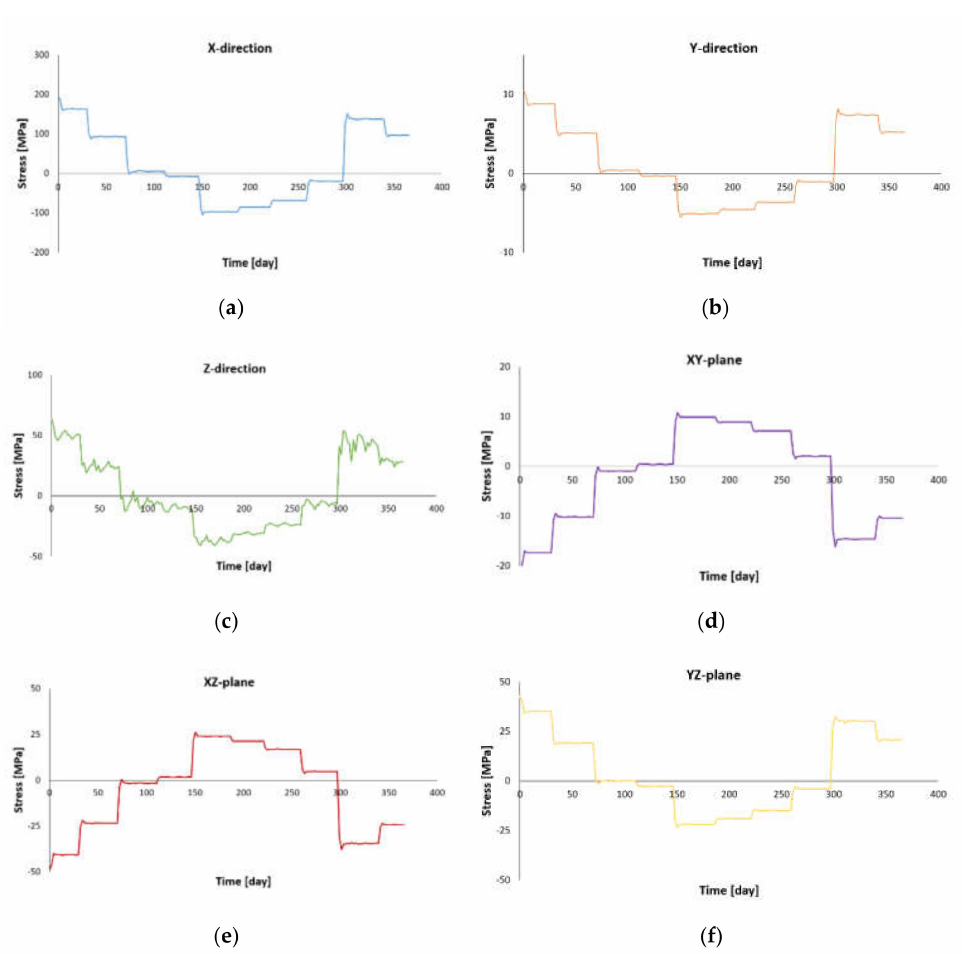
Figure 12. The time histories of stress components of Element No. 38732 due to temperature variations (coupling structural- thermal analysis), including ( a ) Normal stress in X-direction, ( b ) Normal stress in Y-direction, ( c ) Normal stress in Z-direction, ( d ) Shear stress in XY-plane, ( e ) Shear stress in XZ-plane, and ( f ) Shear stress in